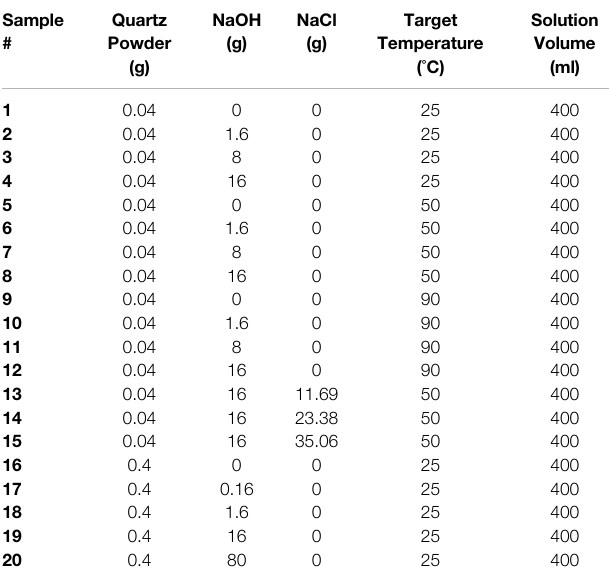
TABLE 1 | Summary of the constituent information for all the batch dissolution experiments that have been performed here. The quartz powder used has a BET surface area of 1.722 m 2 /g. Note that the target temperature is slightly different from the actual experimental temperatures which have been measured and given in Table 2